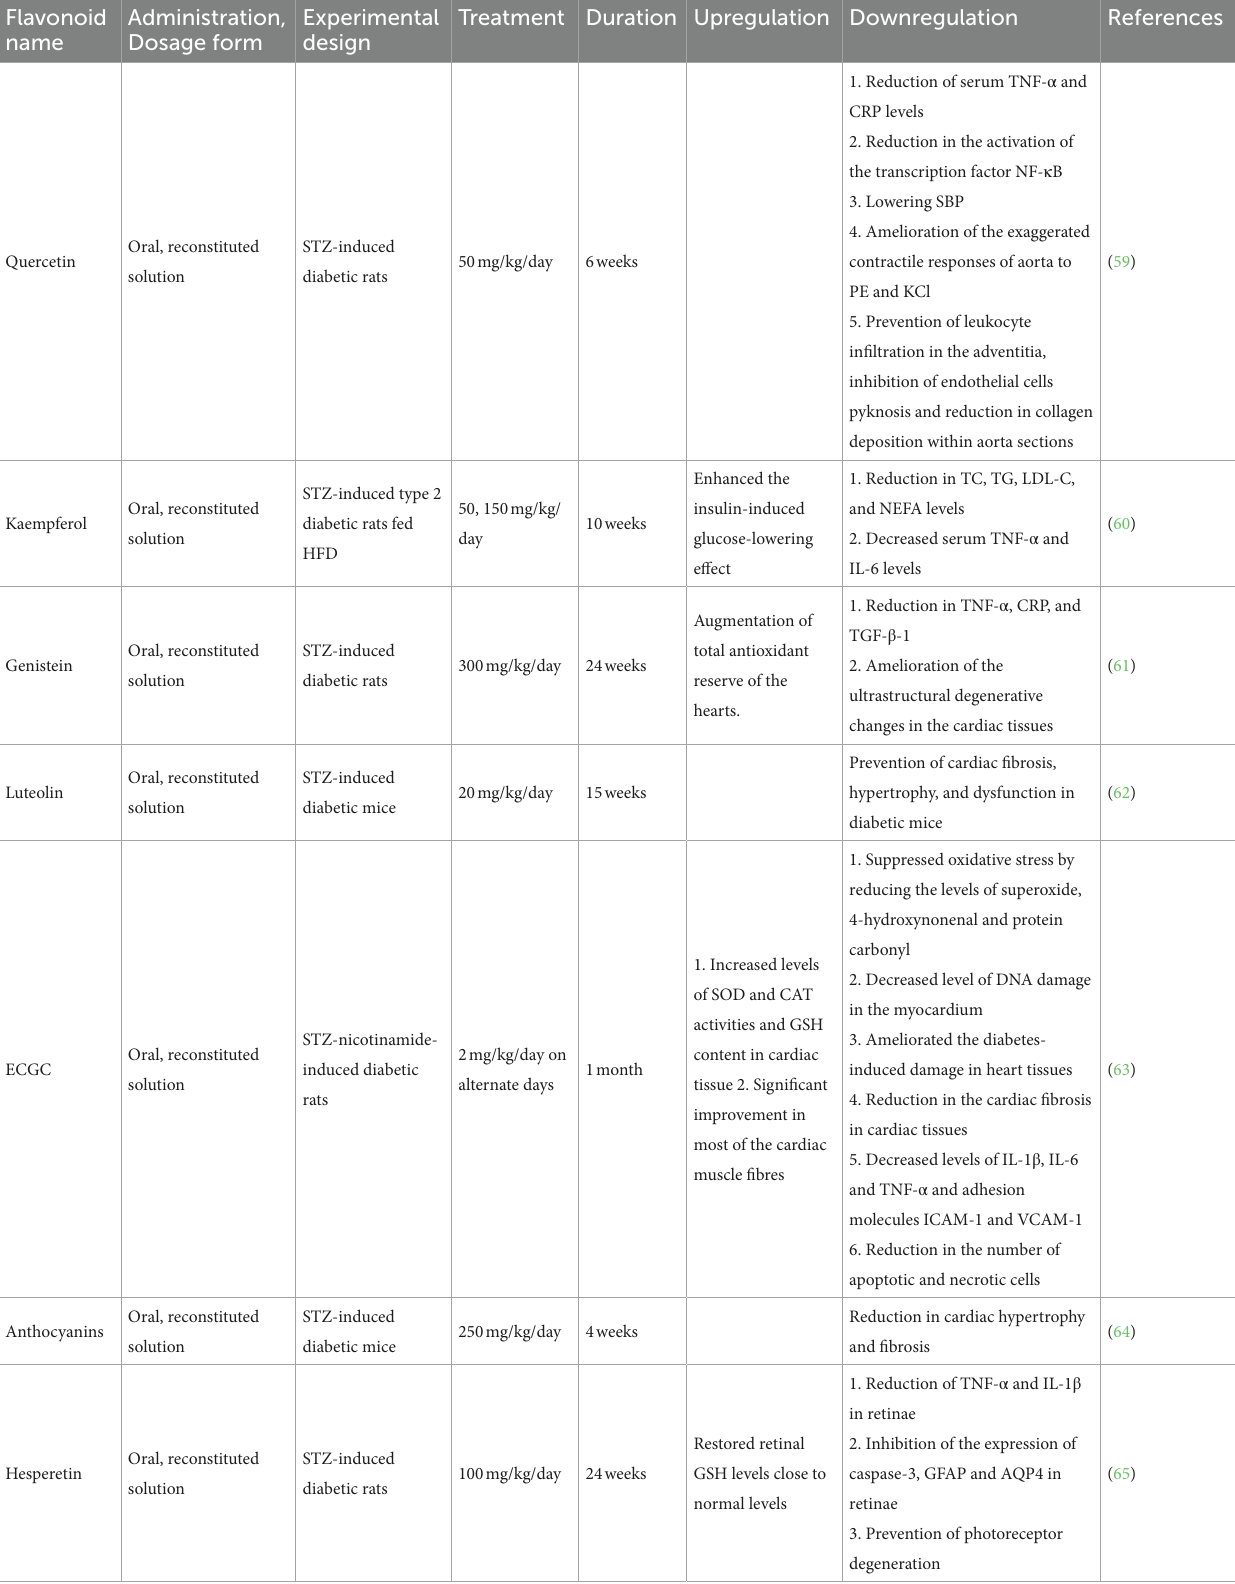
TABLE 2 Protective effects of flavonoids against diabetic complications—animal study